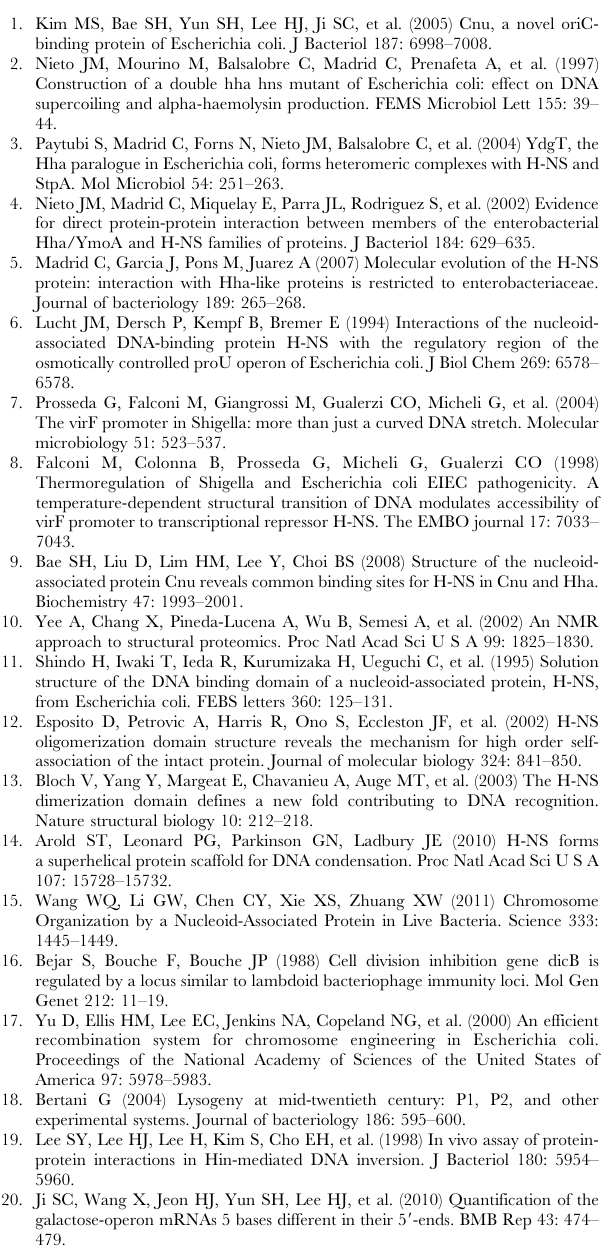
Figure S1 Elution profile of His-Cnu and His-CnuK9E from a Nickel-affinity column. (TIF) Figure S2 Overproduction of DicA protein. (TIF) Figure S3 Identification of 5 9 -end of the dicC transcript. Table S1 Primers used in this